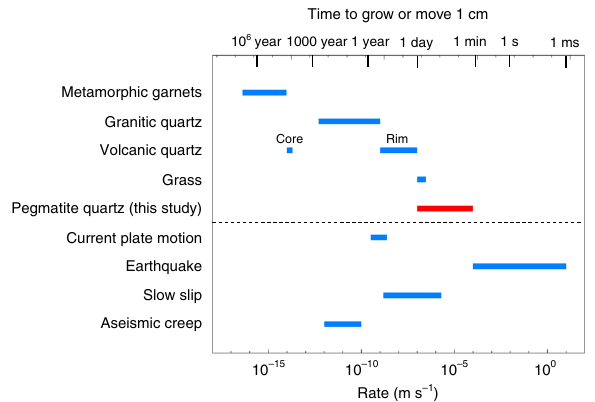
Fig. 9 Comparison of pegmatite crystal growth rates from this study to rates of other geologic processes. Data sources: metamorphic garnets 45,46 ; granitic quartz 47 ; volcanic quartz 48,49 ; grass 62 ; plate motions 50 ; seismic rates 51 (and references